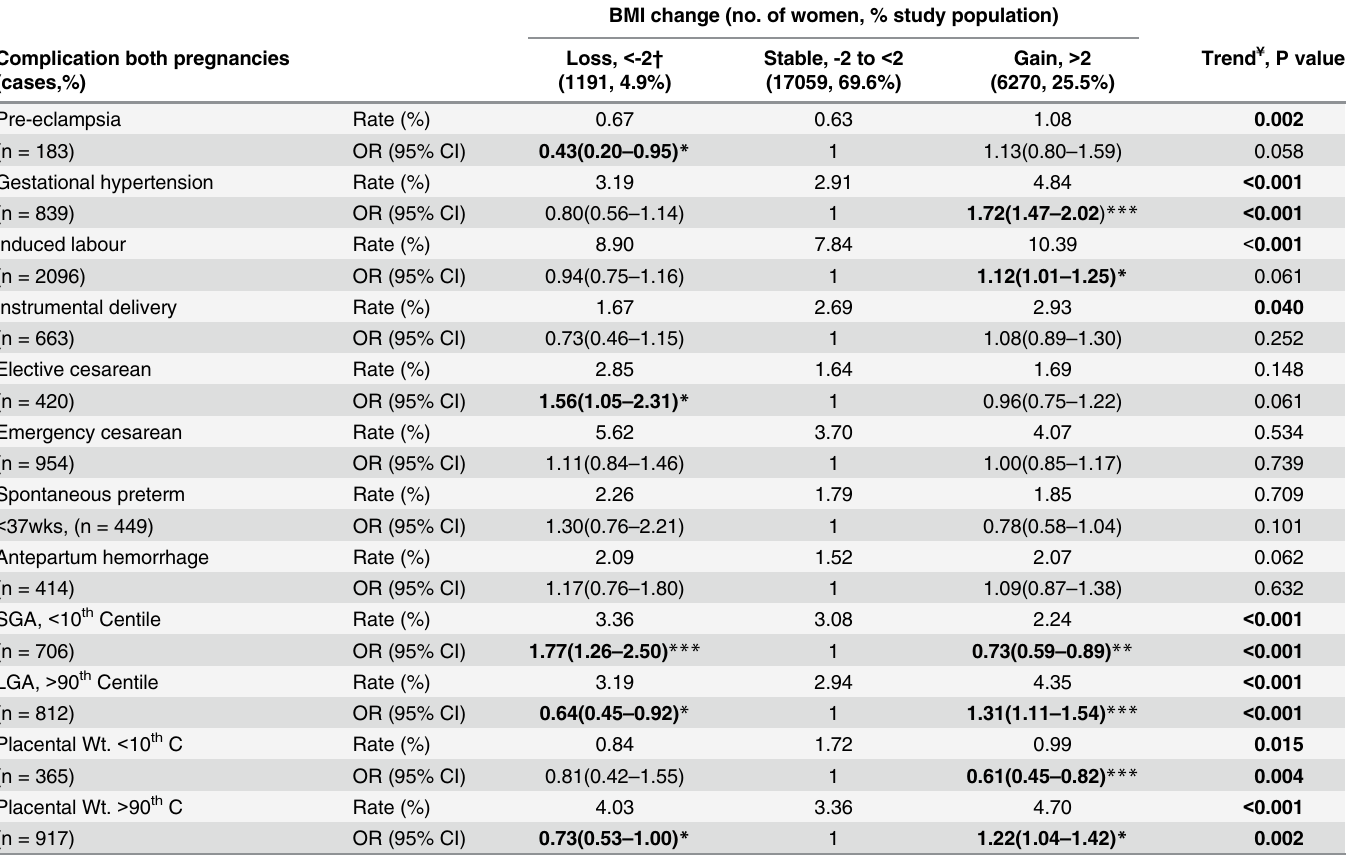
Table 4. Frequency rate and adjusted odds ratios for recurrent adverse perinatal outcomes in first and second consecutive pregnancies in relation to BMI change from first pregnancy. BMI change (no. of women, % study